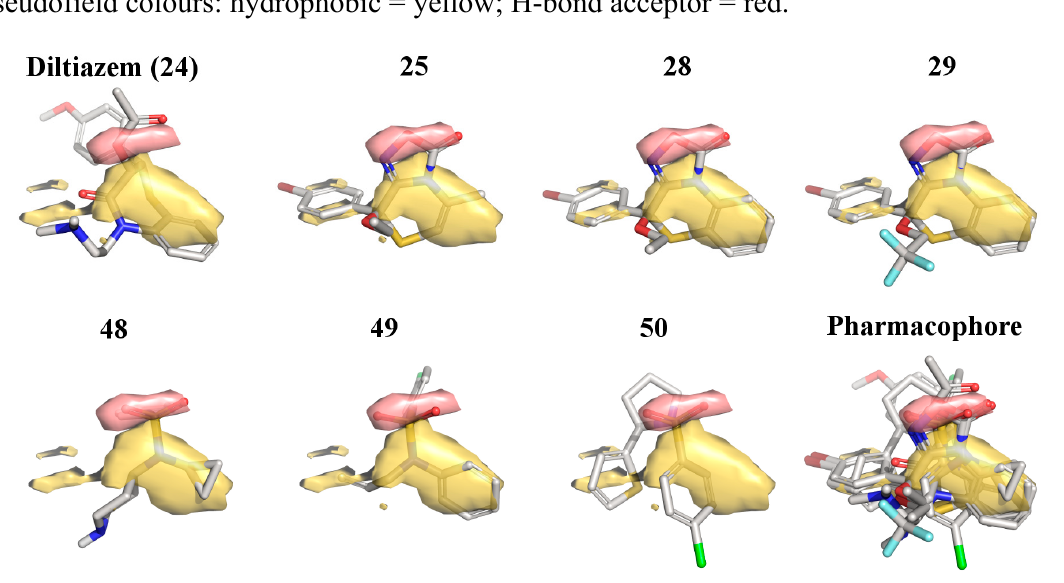
Figure 5. Pharmacophore model obtained with seven molecules: diltiazem ( 24 ), three oxadiazolothiazinones ( 25 , 28 , and 29 ), and three compounds from [36] ( 48 , 49 , and 50 ). Pseudofield colours: hydrophobic = yellow; H-bond acceptor =